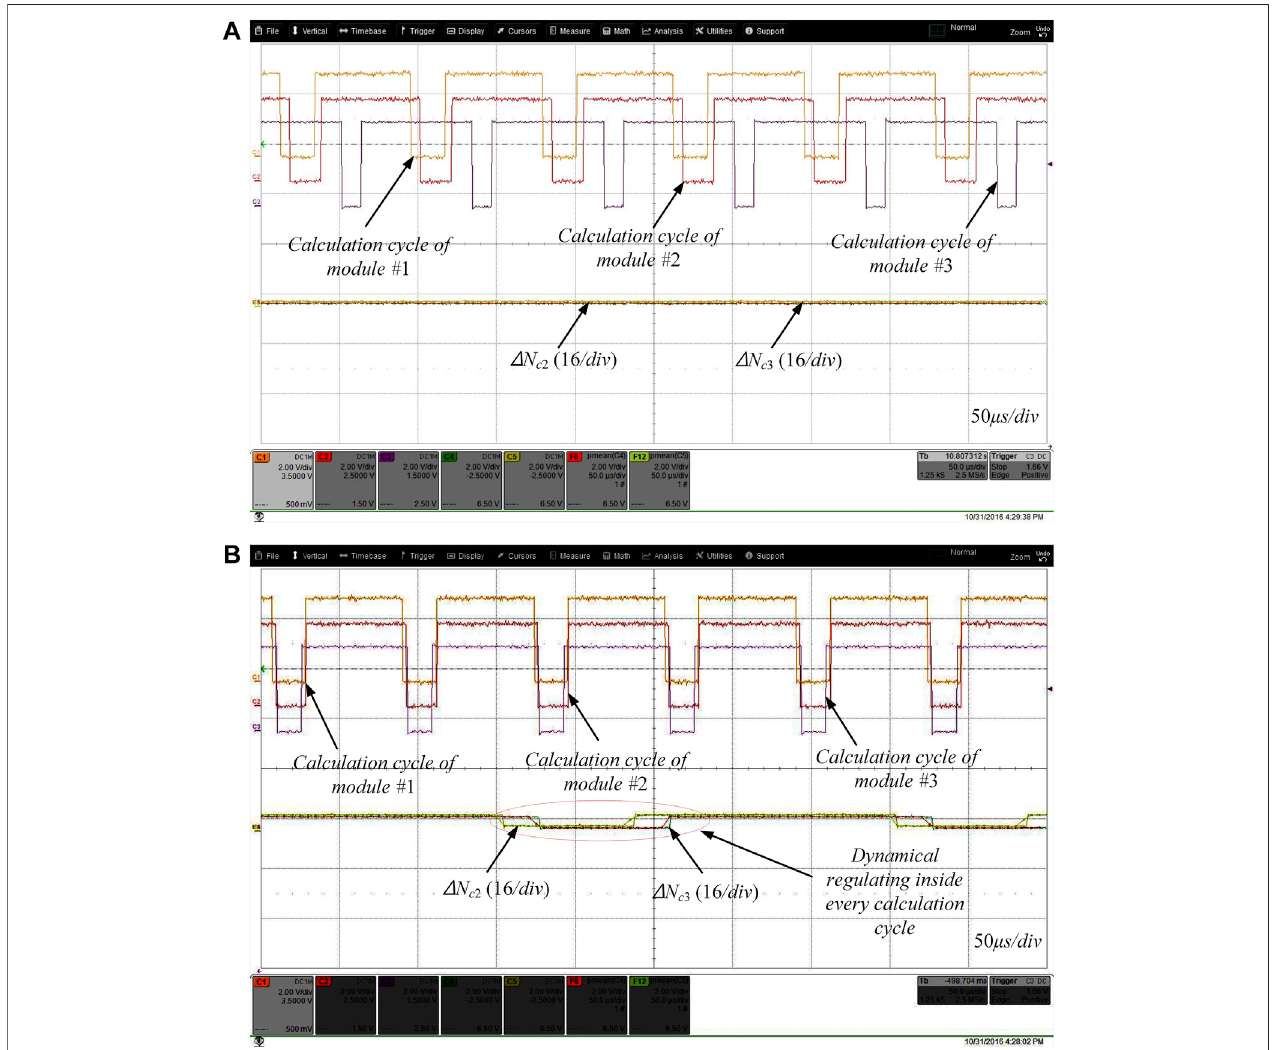
FIGURE13| Experimental resultsofthelowbandwidthsynchronization: (A) Zooming-in oftheexperimentresultswhenwithoutsynchronizationand (B) Zooming- in of the experiment results when with synchronization.